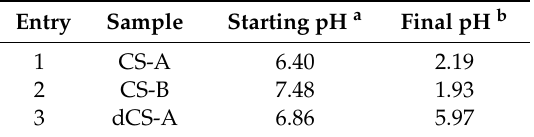
Table 2. Progressive dissolution of CS-A, CS-B and dCS-A in aqueous acidic solution. Entry Sample